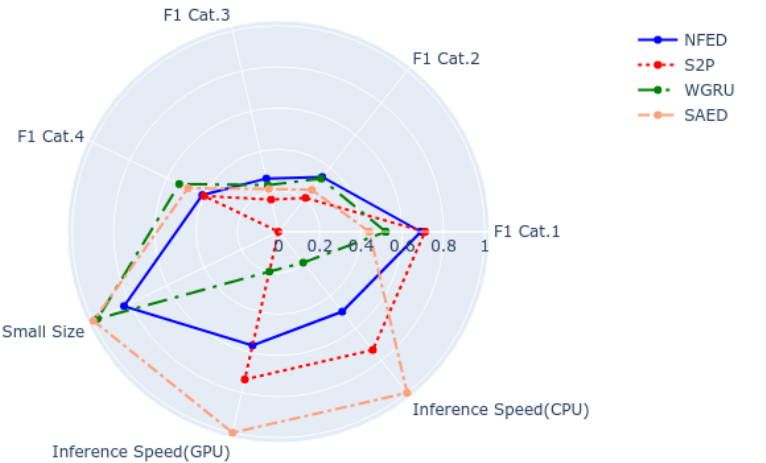
Figure 9. Diagram that summarizes the capabilities of the models to disaggregate a dish